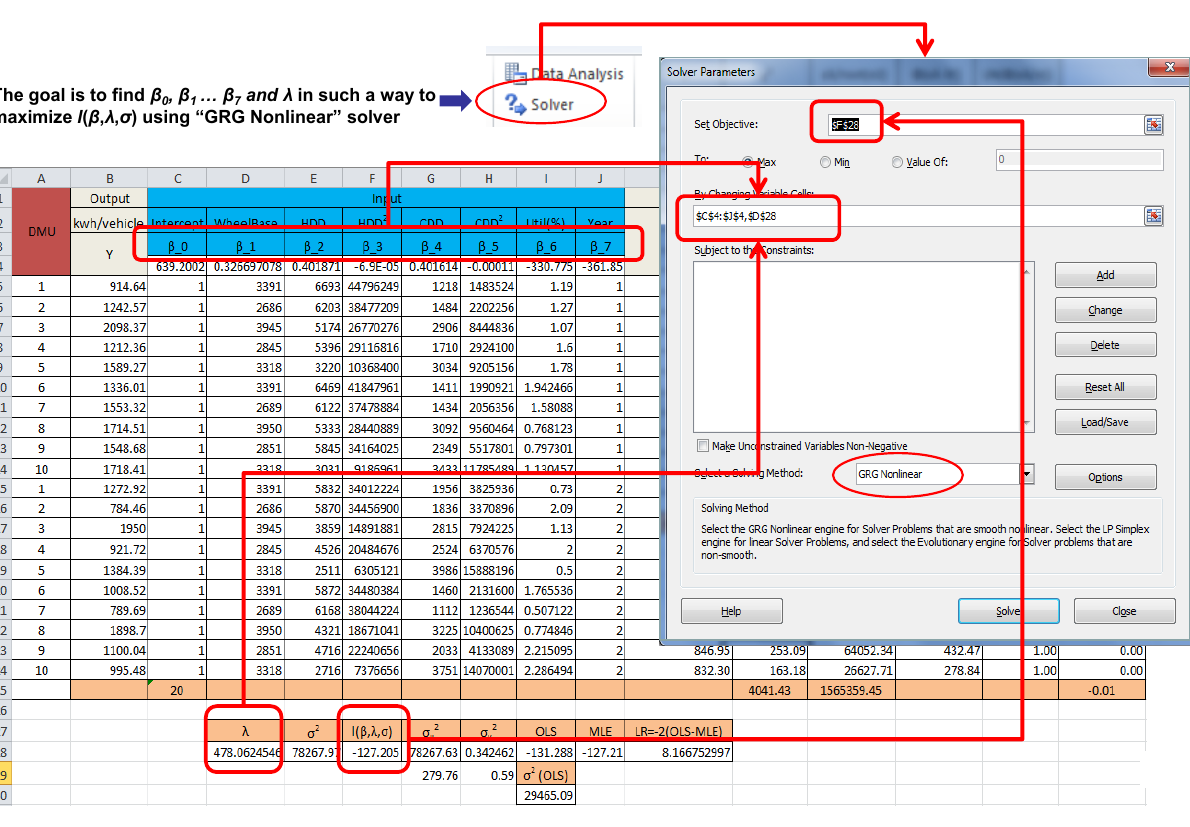
Figure 7. SFA model estimation using MS-Excel Solver with “GRG Nonlinear”